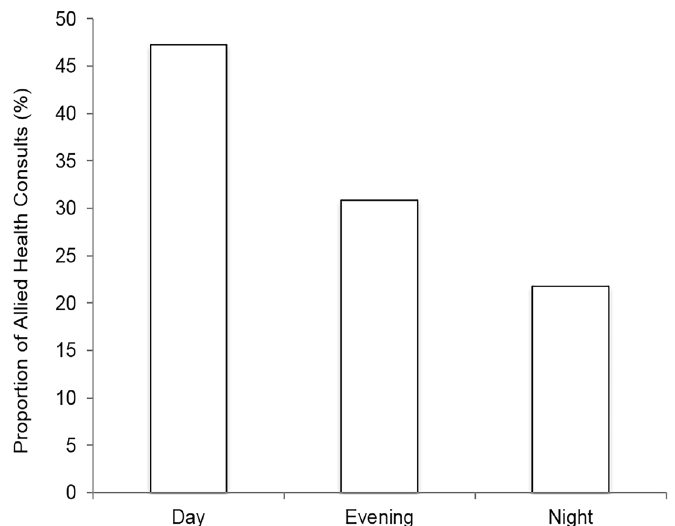
Figure 4. Proportion of Allied Health consults by time of presentation. n=203 allied health consultations during 188 of 3164 possible visits. Allied health consultants included social work, geriatric emergency medicine nurses, or community care access